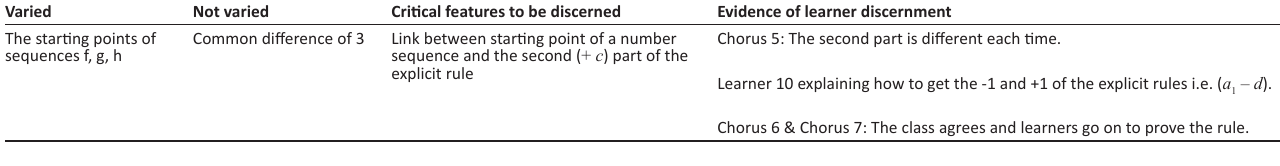
TABLE 3: Summary of discernment unit 3. Varied Not varied Critical features to be discerned The process or The sequences a, b, representations from numerical, recursive and explicit to table form